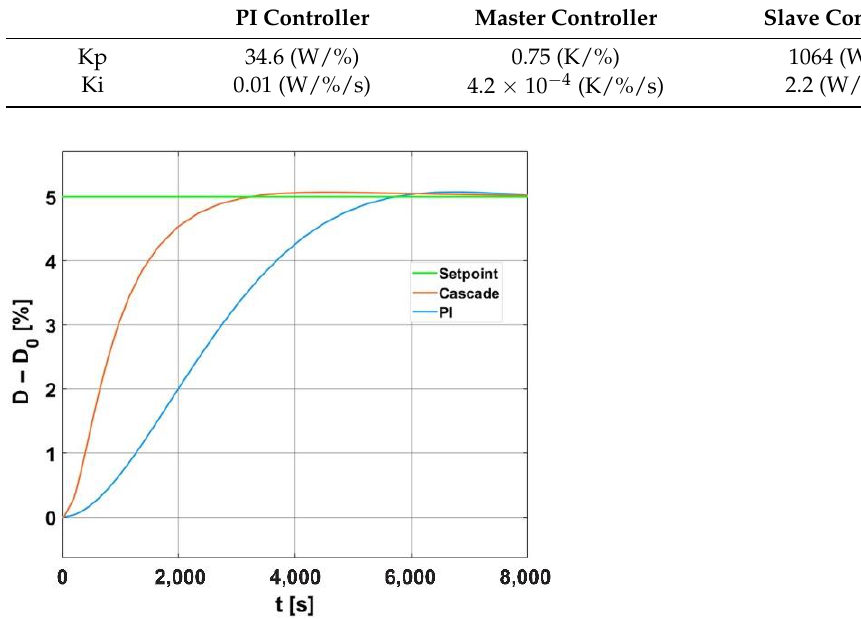
Figure 25. Simulation runs of tape dryness adjustment using both adjustment variants.